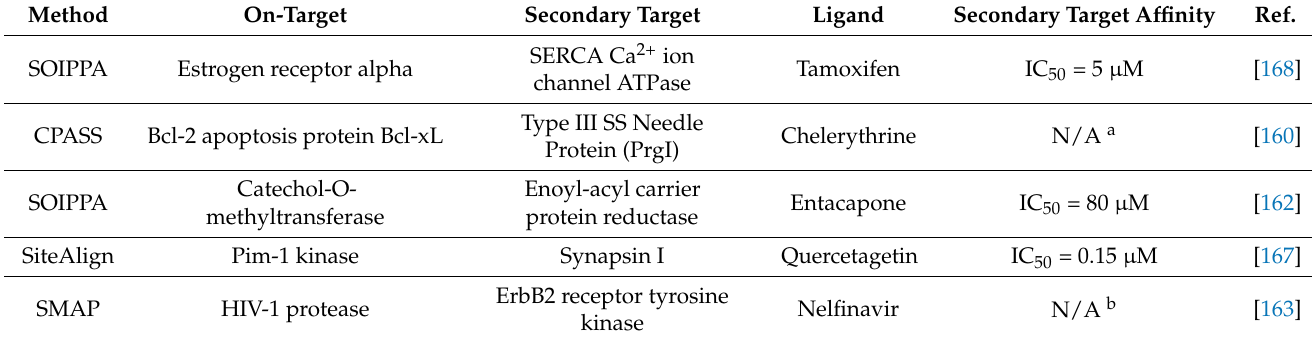
Table 5. Examples of small molecular weight ligand-binding site comparisons relevant to medici- nal